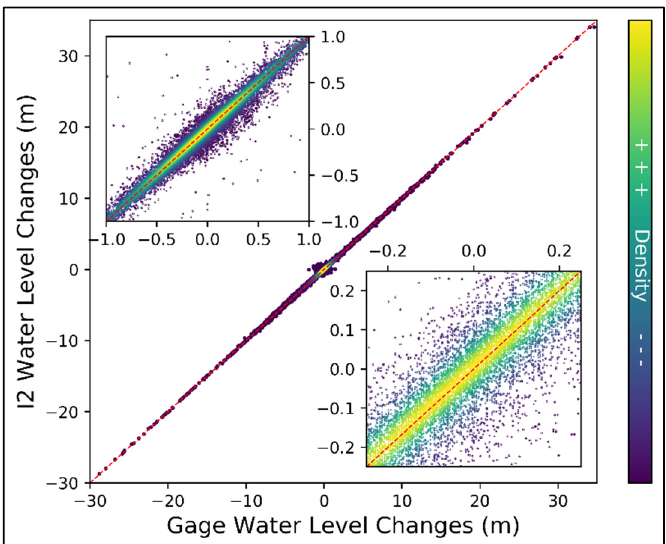
Figure 5. Gage (IV) derived relative water level changes versus “strong” beam IS-2 derived relative water level changes. The units for the main plot and the two subplots are in meters. The one-to-one line is plotted as a dashed red line. The points are colored by their respective density. Two zoomed inset maps are present and are focused at the origin point 0,0. The water level comparisons in the upper-left inset range from –1 m to +1 m and the comparisons in the lower-right range from − 0.25 m to +0.25 m. The IS-2 water level changes are from the ATLAS “strong” beams only. We plot a frequency histogram of those differences in Figure 6 in order to better ex- amine the spread of the relative water residuals. This plot shows that ~97% (18,214) of the 18,690 temporally overlapping “strong” beam IS-2 derived water level change measure- ments are within ±25 cm of their gaged (IV) counterparts. Furthermore, ~81% (15,085) and ~55% (10,372) of the IS-2 water level changes are within ±10 and ±5 cm of their correspond- ing in situ gaged measurements, respectively. It is evident that the vast majority of our IS- 2 derived water level changes are quite accurate as compared to their temporally overlap- ping in situ gaged counterparts. These results are proof positive that IS-2 ATLAS photons can meaningfully monitor water level changes at the continental scale for a variety of sur- face waterbody types. Figure 6. Frequency histogram of the residual differences from the “strong” beam IS-2 and gaged relative water level changes. Each bin is 50 cm wide and is centered on the 0 cm residual difference. Note that the y -axis unit is the percentage of IS-2 and gaged comparisons with residual water level differences within each particular bin’s range. The y -axis is on a base 10 logarithmic scale in order